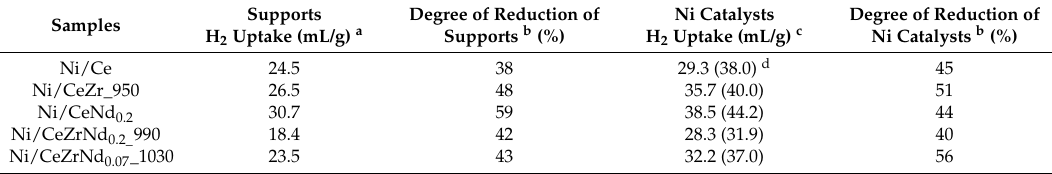
Table 3. Quantitative results from TPR profiles of the supports and Ni-supported catalysts.